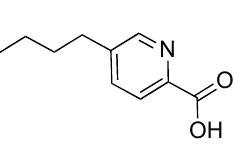
Figure 9. Fusaric acid, a fungal toxin isolated from Fusarium oxysporum.